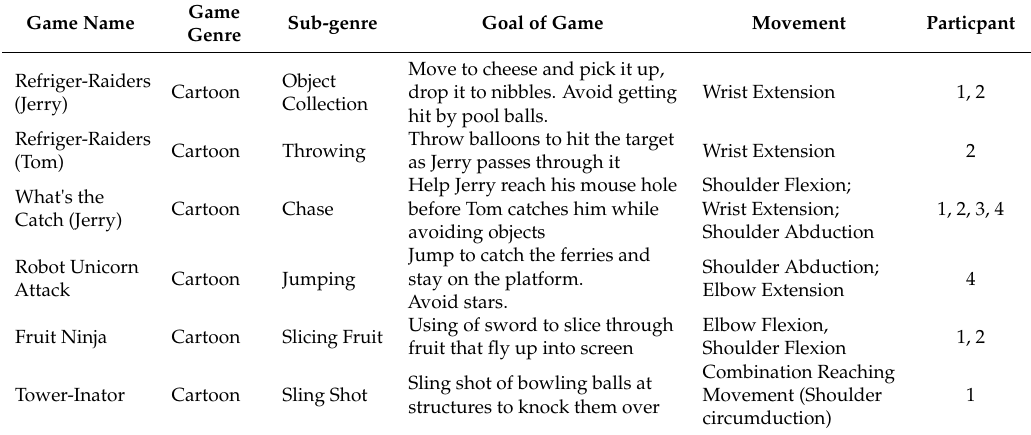
Table 1. List and description of the 26 games played by the children during the